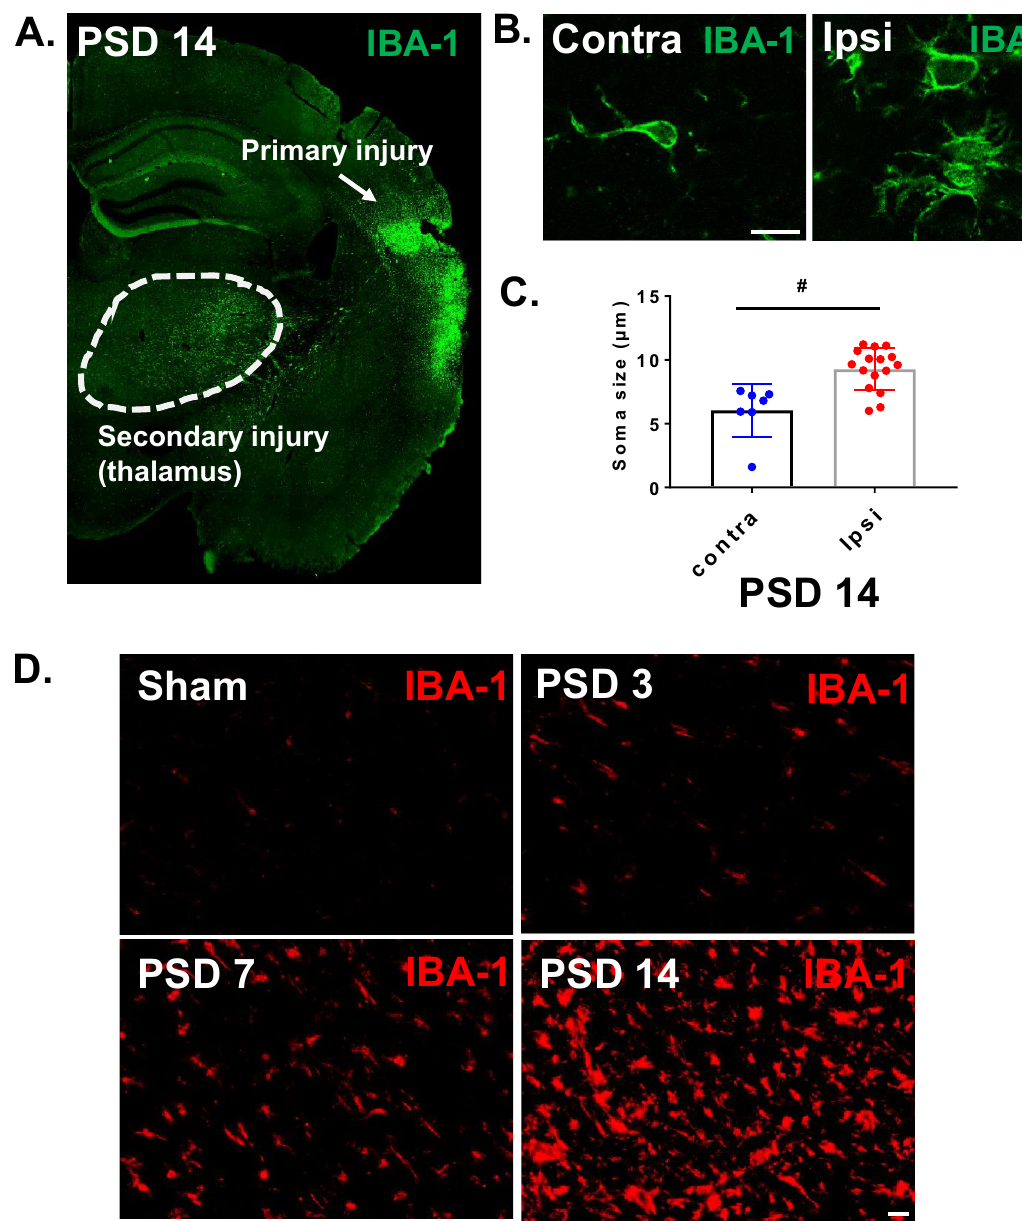
Figure 1. Cortical stroke induces delayed microglial activation in the thalamus. Cortical infarction was induced in young C57BL/6 J mice. At 3 days, 1 week and 2 weeks after stroke, brains were isolated and sectioned. Immunostaining with anti-IBA-1 antibody was performed. Brain sections at − 2 mm from bregma were used for the visualization of thalamic microglial activation. ( A ) Coronal brain section showing activated MG/ macrophages (IBA-1) in the posterior region of the primary injury and in the ipsilateral thalamus at PSD 14 (10X obj, stitched image). ( B ) Enlarged images showing morphology of MG/macrophages in the ipsilateral and contralateral thalamus at PSD 14 (scale bar = 10 µm, 63X obj). ( C ) The microglial soma size, located in the ipsilateral thalamus, is much bigger than microglia in the contralateral thalamus (# p < 0.05, unpaired t test) ( D ) Time course of IBA-1 staining showing delayed MG/macrophage activation in the ipsilateral thalamus (scale bar = 20